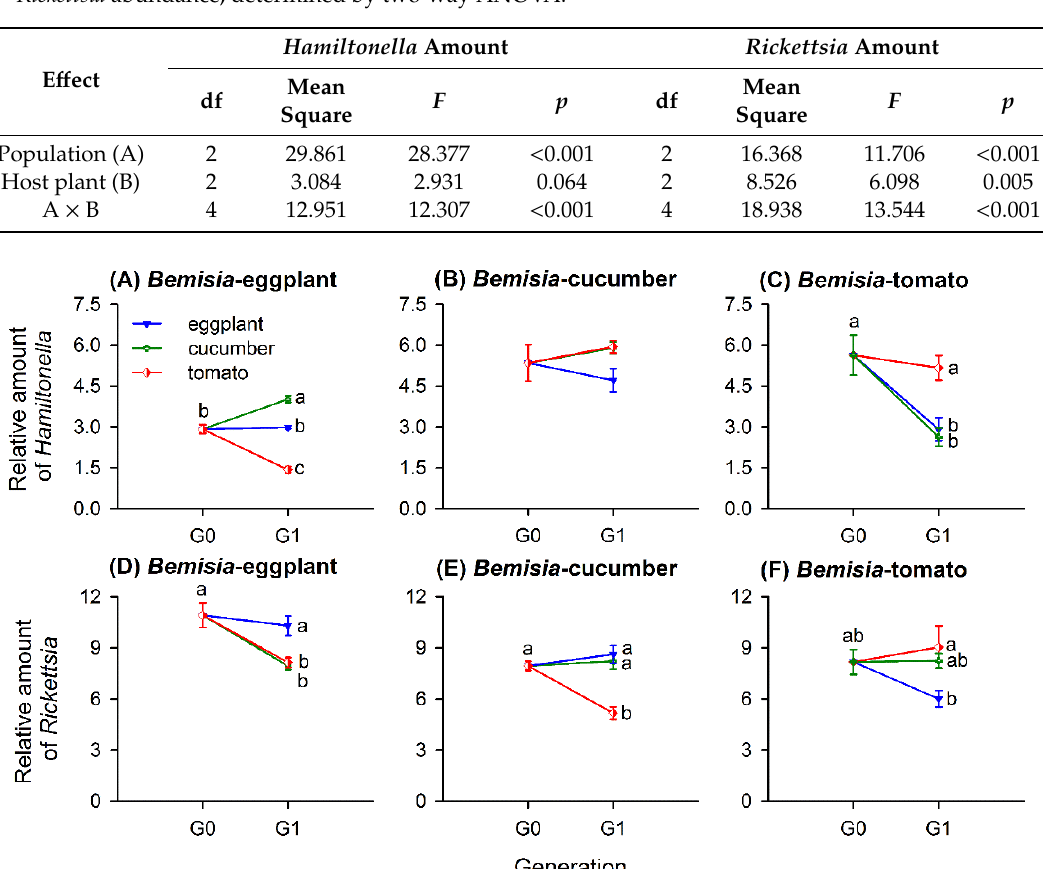
Table 3. Effects of the B. tabaci population and host plant since host-plant-shifting on Table 3. E ff ects of the B. tabaci population and host plant since host-plant-shifting on Hamiltonella and Hamiltonella and Rickettsia abundance, determined by two-way ANOVA. Rickettsia abundance, determined by two-way ANOVA.